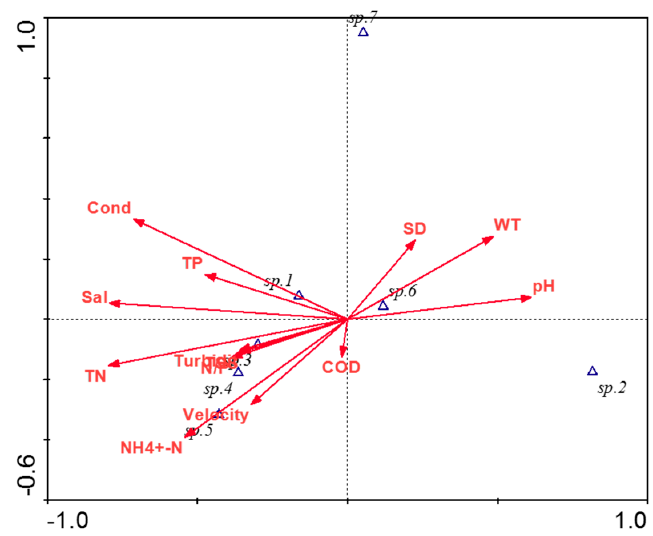
Figure 7. Canonical correspondence analysis (CCA) ordination diagram of benthic diatoms and environmental factors in the Ying River. (SP. 1–7 refer to Figure 3).